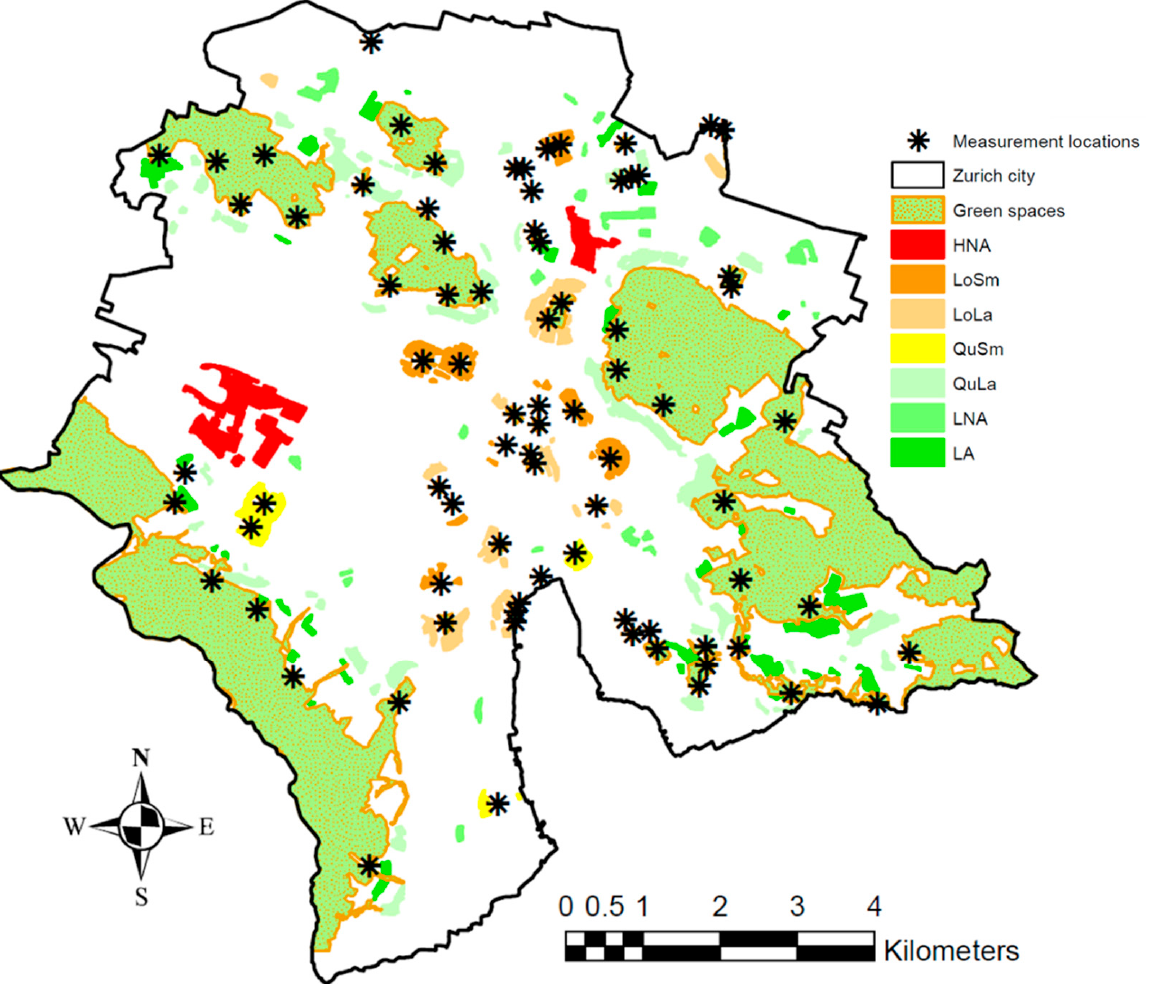
Figure 4. Areas assigned to the seven study groups: High noise exposure at home with no access to GSs (HNA), High noise exposure at home with access to small and loud GSs (LoSm), High noise exposure at home with access to large and loud GSs (LoLa), High noise exposure at home with access to small and quiet GSs (QuSm), High noise exposure at home with access to large and quiet GSs (QuLa), Low noise exposure at home with no access to GSs (LNA) and Low noise exposure at home with access to large and quiet GSs (LA) (cf. Figure 1). As additional information, the 48 GSs included in the study and the 78 measurement locations in these GSs (see Section 2.4) are shown.